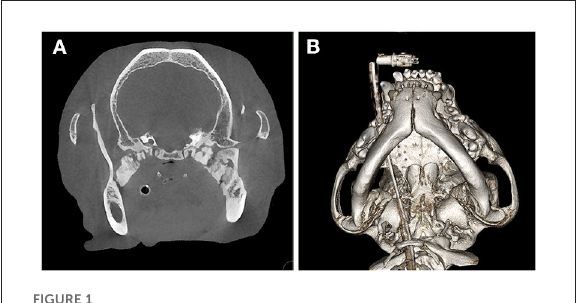
FIGURE1 Cone beam CT images for the dog described in Case 1. (A) CT image demonstrating bilateral smoothly margined, dense osseous proliferation in the location of the lateral pterygoid muscles, spanning the region of the medial pole of the condylar process and tympanic bulla to the medial aspect of the caudal body of the mandible. (B) A 3D reconstruction of the same scan, viewed from the ventral